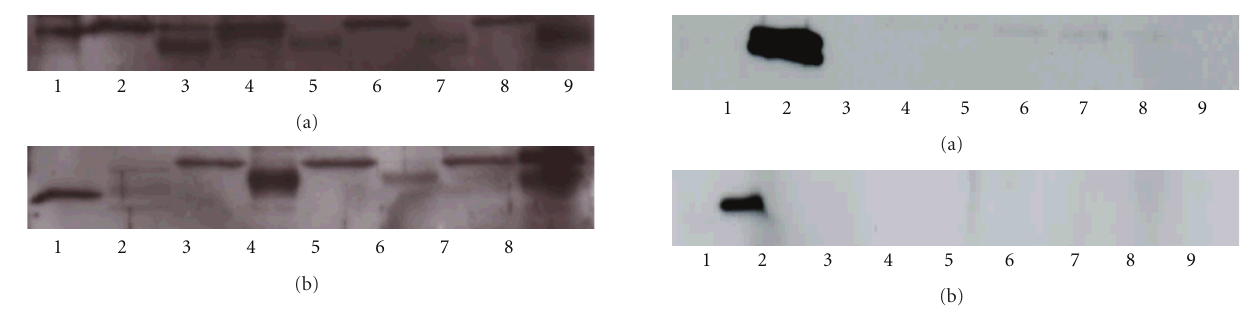
Figure 2: Representative western blots with a polyclonal antibody directed against LMP2 or LMP7 subunits of the immunopro- teasome of samples of BAL supernatant obtained from healthy subjects. (a) LMP2 immunoproteasome protein could not be detec- ted in BAL supernatant of any healthy subject. Lanes are